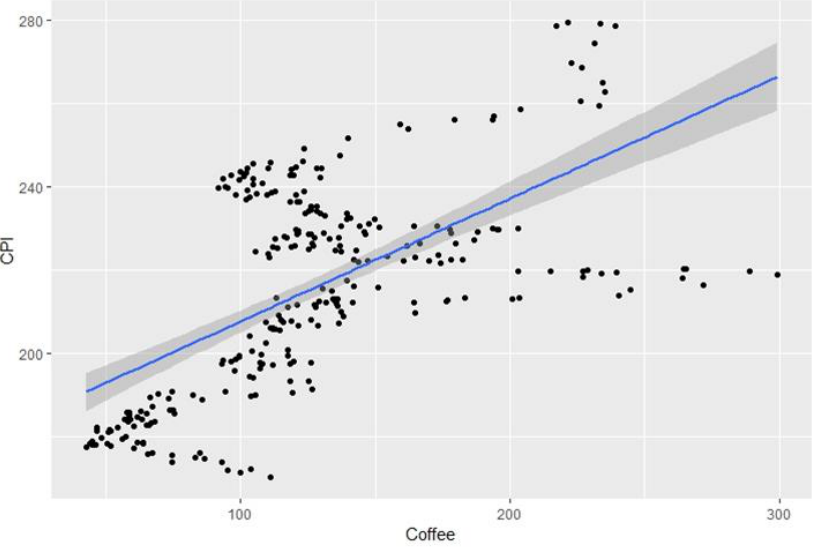
Figure 4. Linear regression based on Pearson correlation coefficient between CPI Chicago and Coffee. Own processing based on data from US Bureau of Labor Statistics and Yahoo Finance. The last correlation analysis was performed for Los Angeles (see Figure 5). The same p -value as in the case of the above CPIs indicates the rejection of H 0 . However, the resulting value of the Pearson correlation coefficient was slightly lower (r =